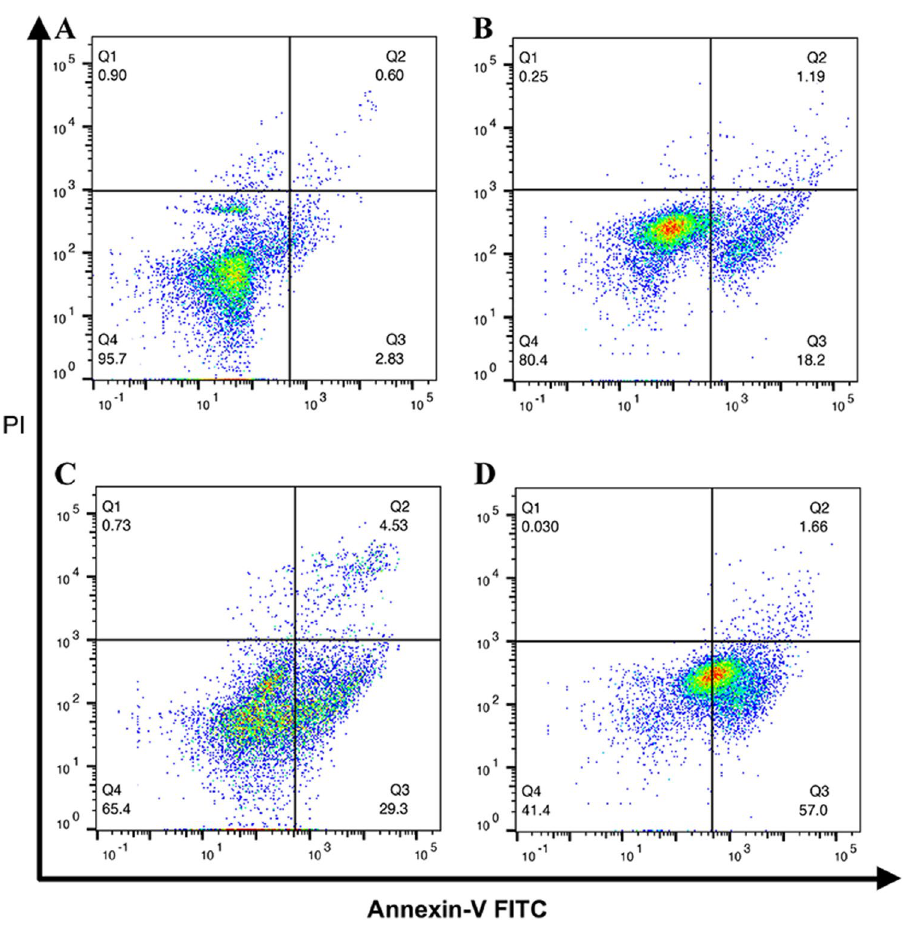
Figure 8. Flow cytometry analysis of cell apoptosis after treated with saline ( A ), GOD@HAZnO ( B ), AS@ HAZnO ( C ), and AS/GOD@HAZnO NPs ( D ) for 24